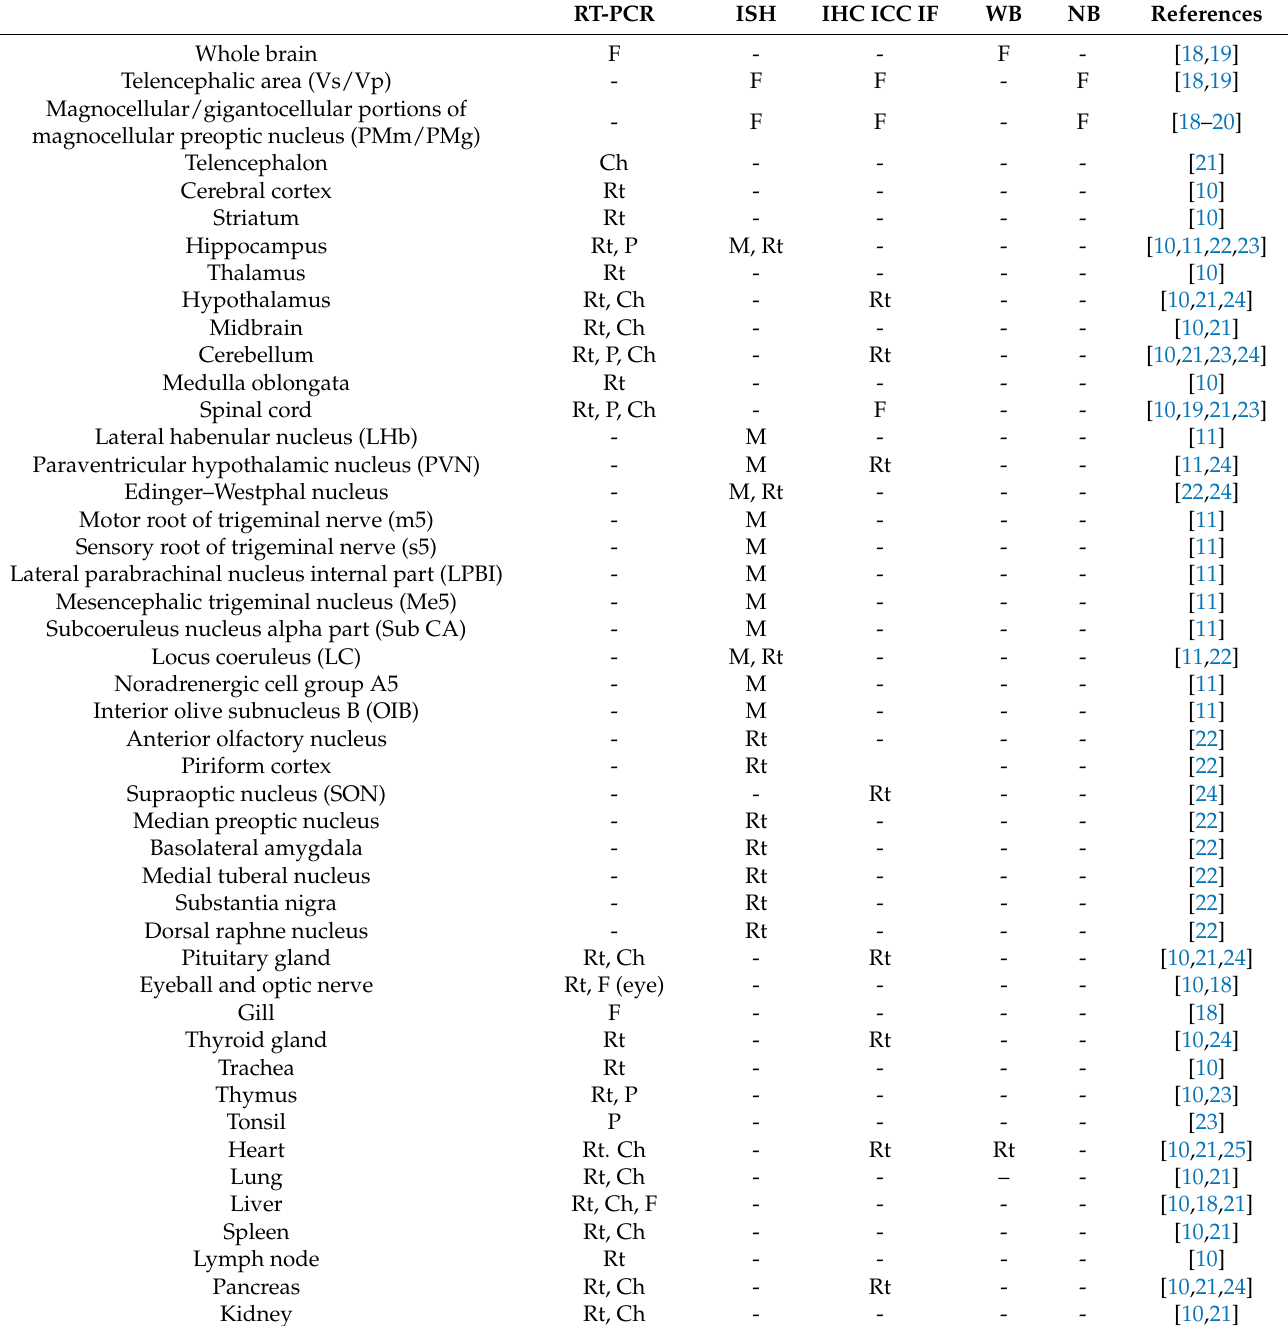
Table 1. Localization of NPB in central nervous system and peripheral